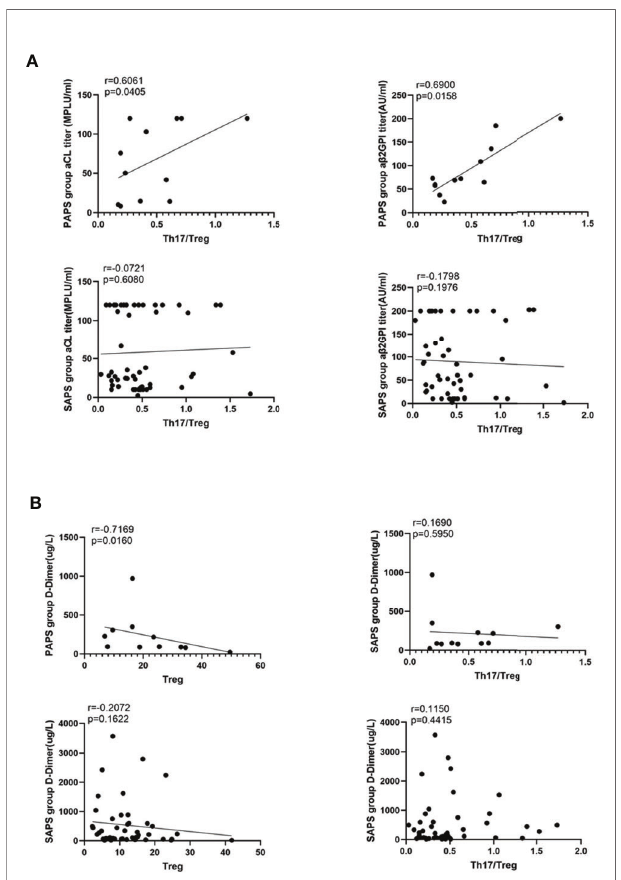
FIGURE 4 | (A) The correlation analysis between the value of Th17/Treg and the titer of aCL and a b 2GPI in PAPS group and SAPS group, respectively. (B) shows the correlation between D-Dimer and Treg cell subset, Th17/Treg value respectively in PAPS and SAPS groups. The linear regression line of the interpolated 95% con fi dence interval curve (broken line) is shown.